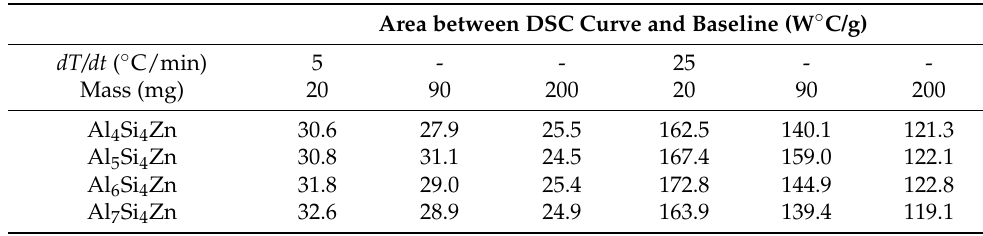
Figure 1. DSC heat flow rate ( y -axis) vs. temperature ( x -axis) curves during melting of the Al X Si 4 Zn alloys, X = 4 ( a – c ), 5 ( d – f ), 6 ( g – i ) and 7 wt.%Si ( j – l ), at 5–25 ◦ C/min with DSC sample masses of 20 ( left ), 90 (middle) and 200 mg ( right ). Table 2. Area between the DSC curves and baseline for the alloys studied here when heated at 5 and 25 ◦ C/min with different sample